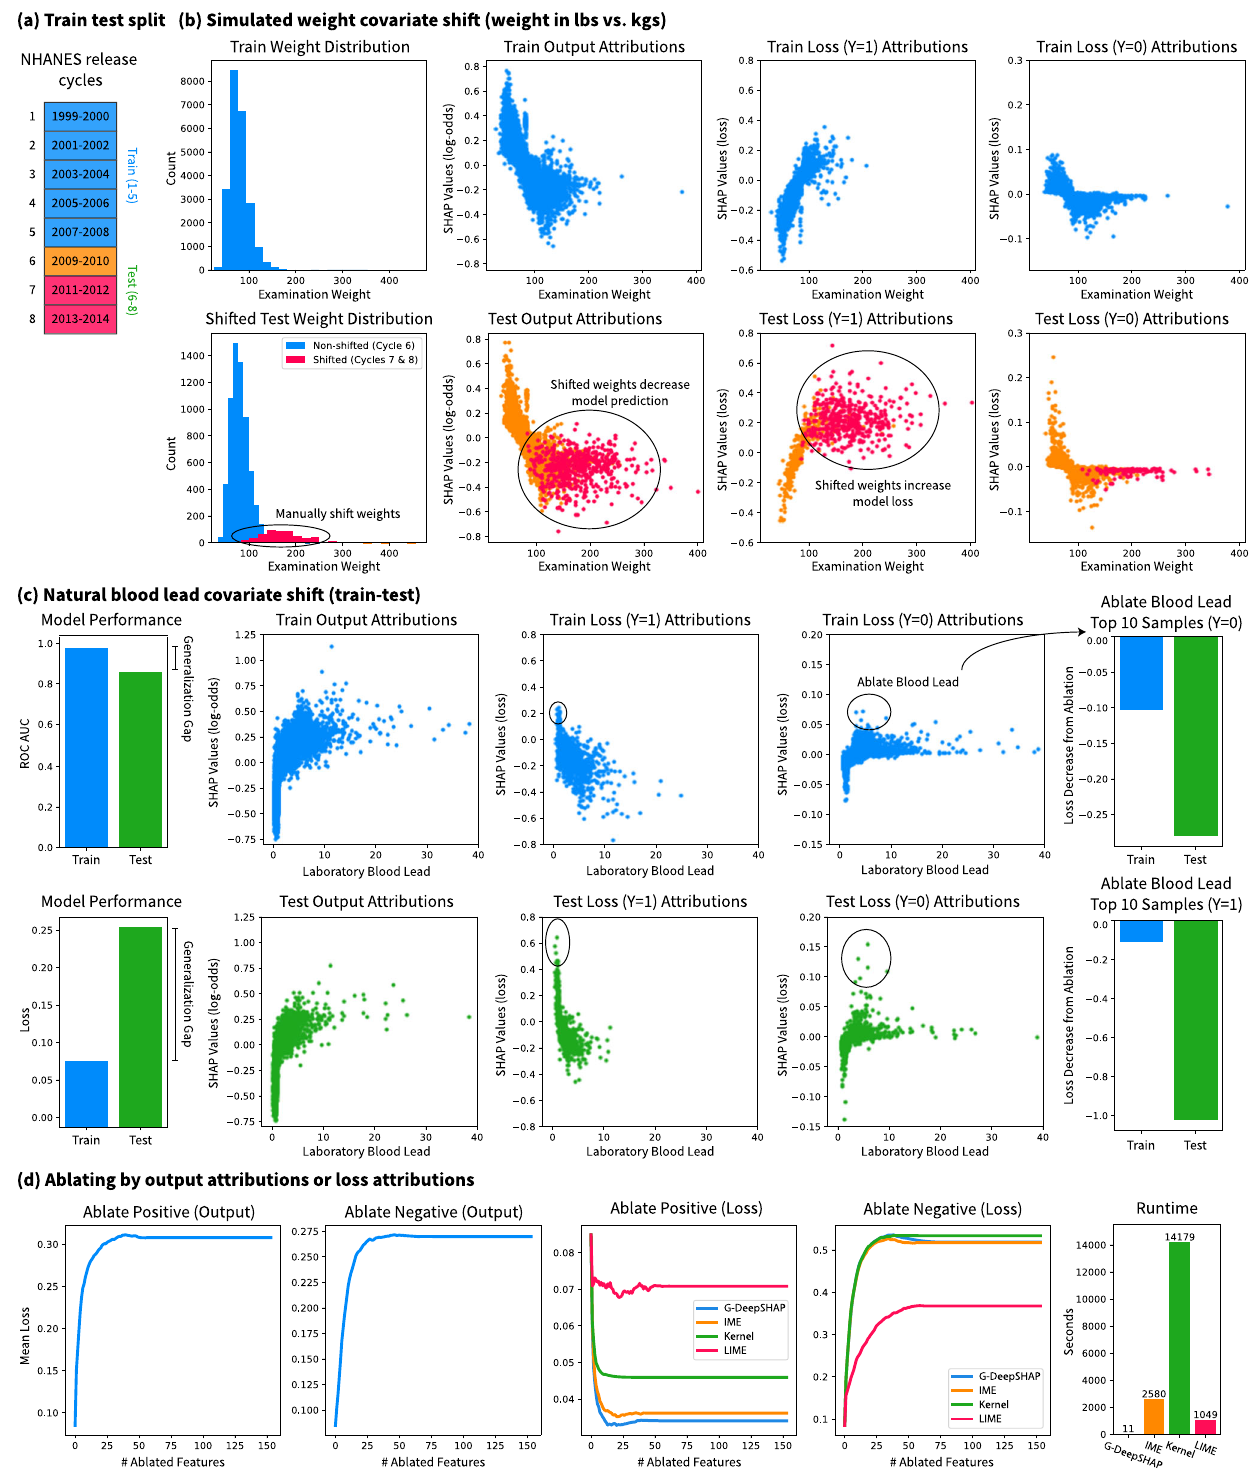
Fig. 5 Explanations of the model ’ s loss rather than the model ’ s prediction yields new insights. a We train on the fi rst fi ve cycles of NHANES (1999 – 2008) and test on the last three cycles (2009 – 2014). ( b ) We identify a simulated covariate shift in cycles 7 – 8 (2011-2014) by examining loss attributions. c Under a natural covariate shift, we identify and quantitatively validate test samples for which blood lead greatly increases the loss in comparison to training samples. d We ablate output attributions (G-DeepSHAP) and loss attributions (G-DeepSHAP, IME, KernelSHAP, and LIME) to show their respective impacts on model loss. We compare only to model-agnostic methods for loss attributions because explaining model loss requires explaining a series of models. Note that ( b ) and ( c ) show dependence plots (Supplementary Methods Section